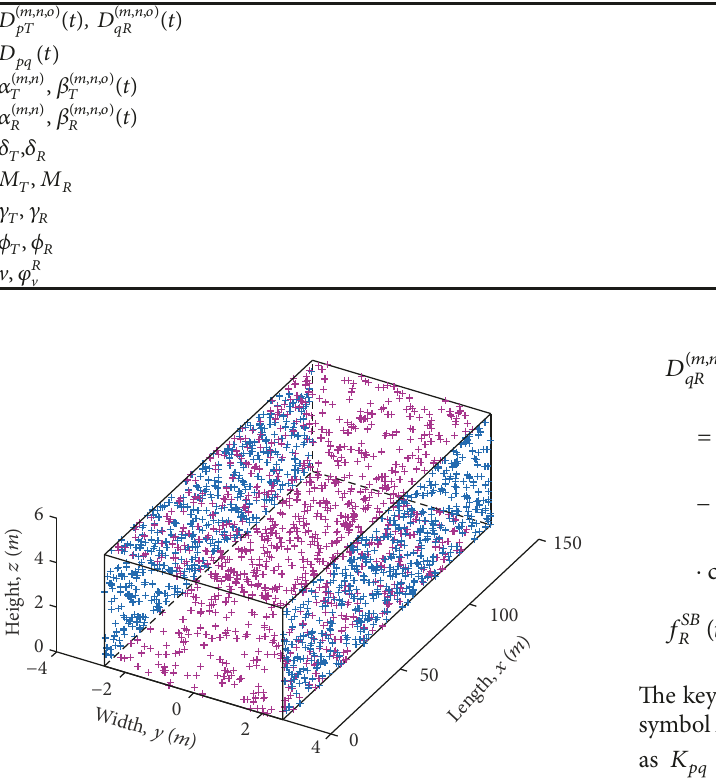
Figure 2: The distribution of